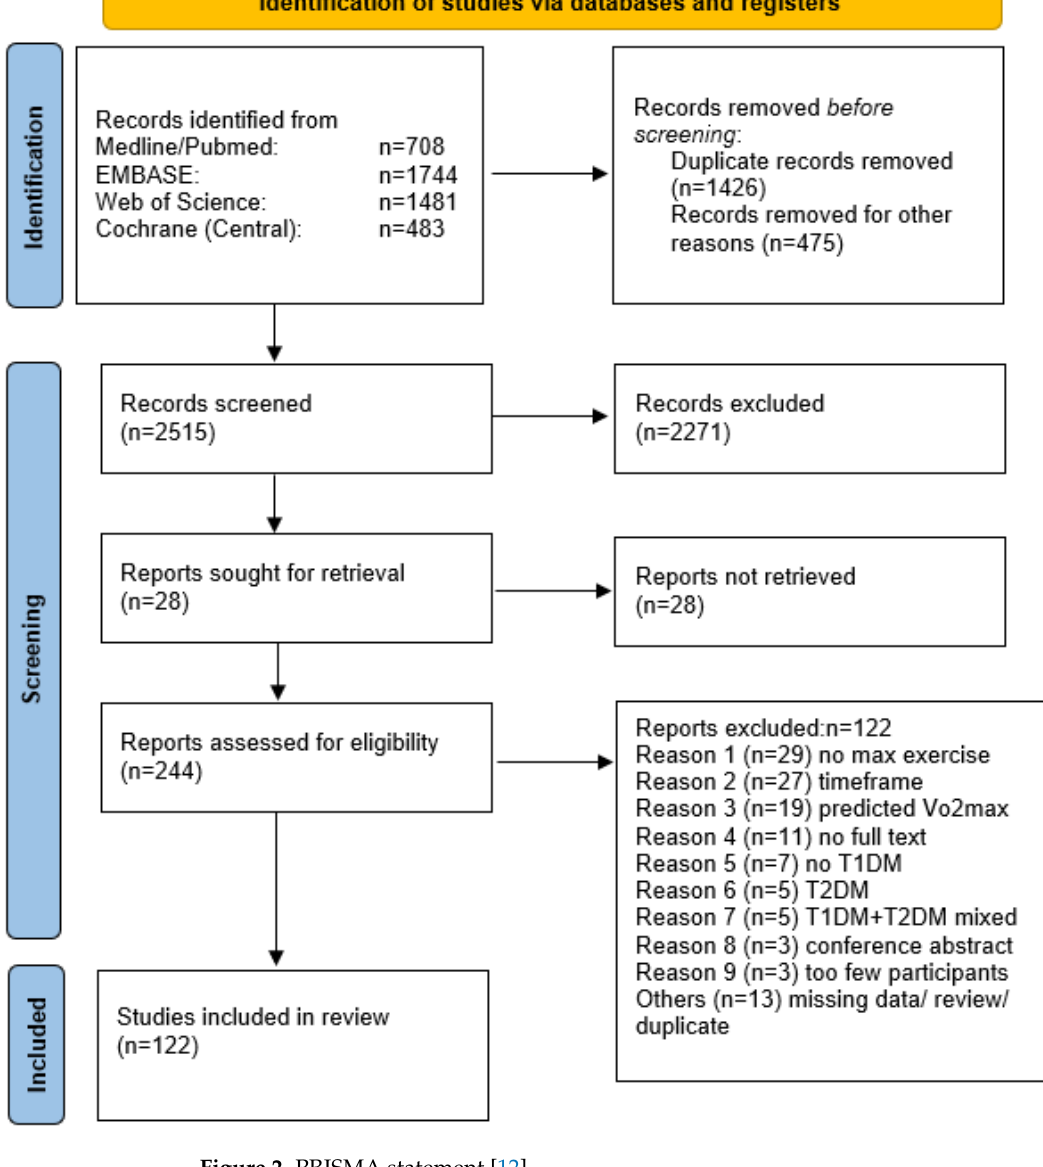
Figure 2. PRISMA statement [12].